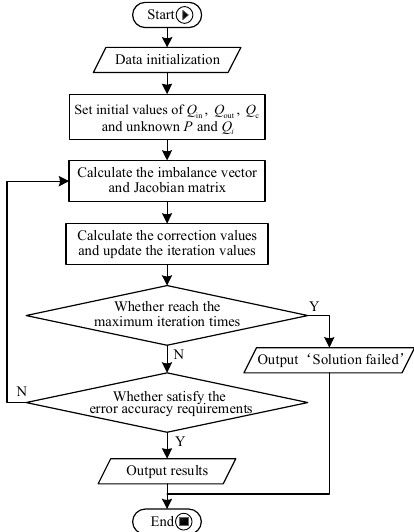
Figure 7. Flowchart for the simulation solution of the steam heating subsystem.